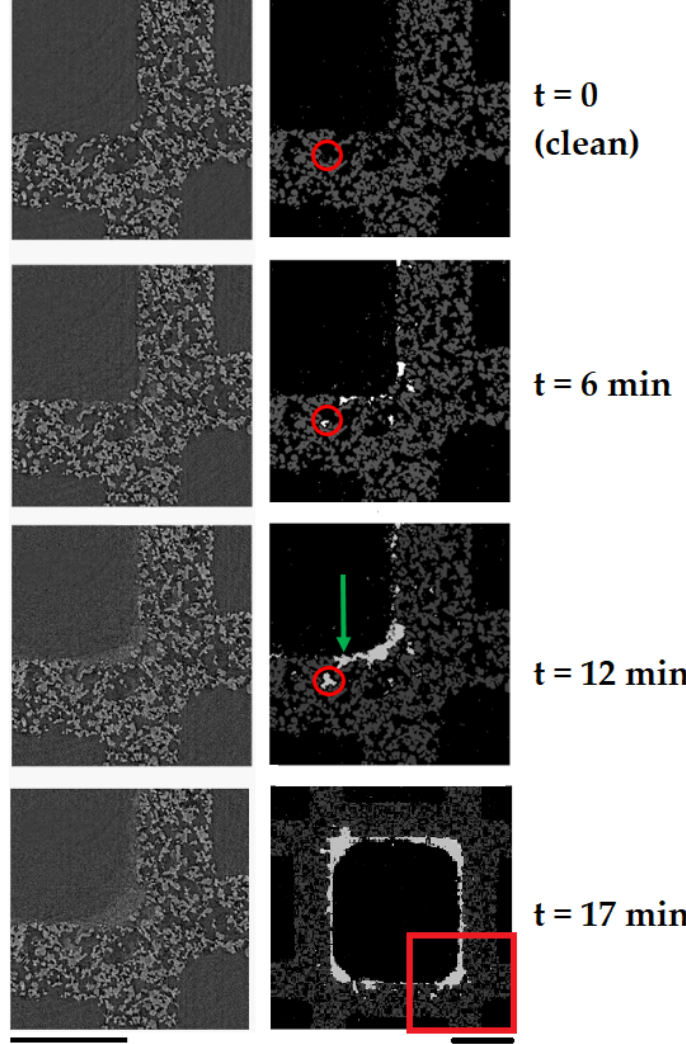
Figure 4. Comparison of greyscale micro-CT virtual slices (left column) and corresponding segmented slices (right column). Slices are 8 mm from the top (upstream) inlet of the sample. TiO 2 aerosol deposits are white, the filter segment is grey and the pore and background segments are black. The red circle tracks a pore filling event that occurred during the time series. The green arrow indicates a pore blocking event caused by the growing cake layer. The final image indicates the position of the previous slices within the channel. Scale bars = 500 µ